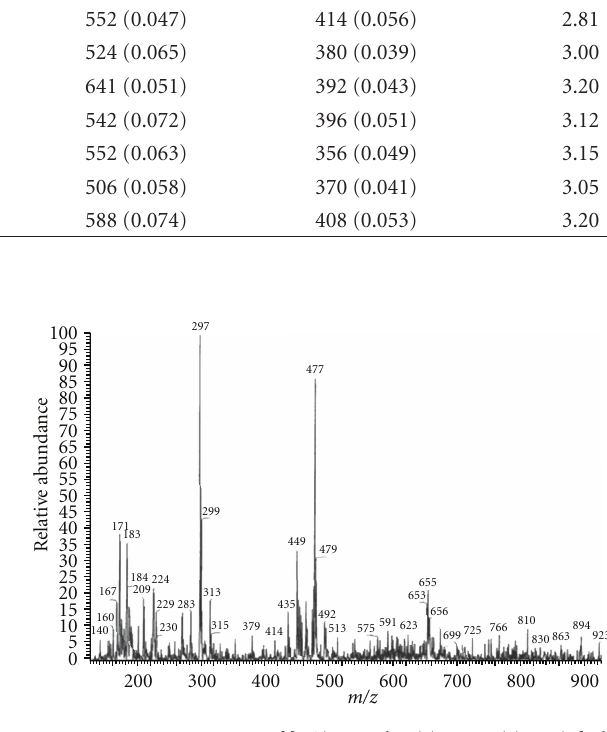
Figure 2: Mass Spectrum of [Ni(1,10-phen)(MIIMP)(H 2 O) 2